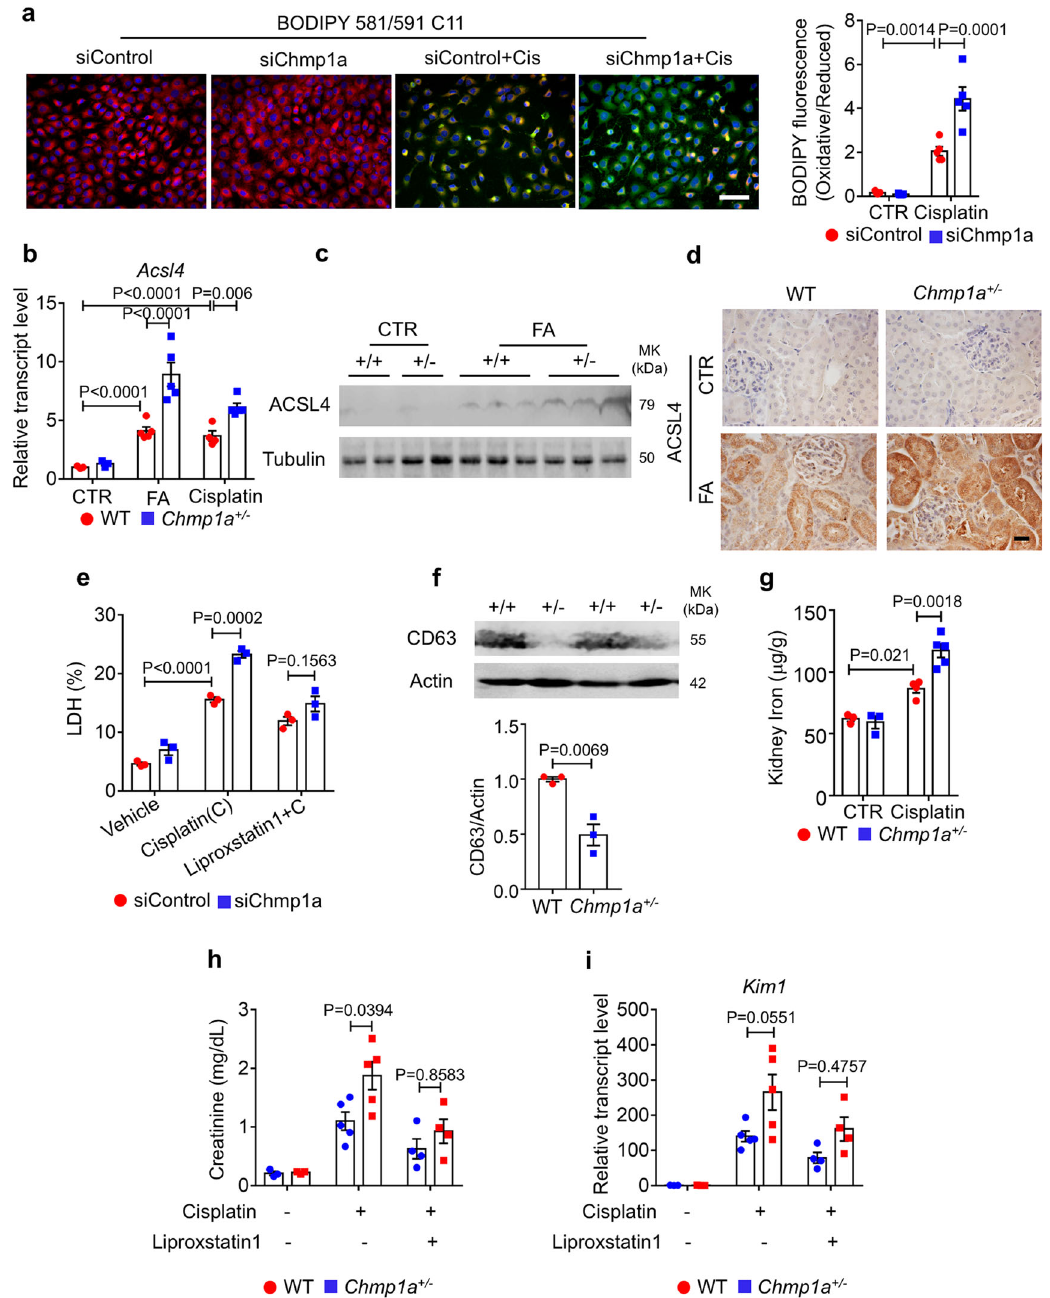
Fig. 7 Chmp1a knockdown enhanced ferroptosis through iron accumulation. a (left) Representative BODIPY 581/591 C11 staining of siControl and siChmp1a transfected cell following sham or cisplatin treatment. Scale bar: 50 μ m. (right) Quanti fi cation of the oxidized vs. reduced probe ( n = 5). b Relative mRNA level of Acsl4 in the kidneys of folic acid and cisplatin-treated wild-type and Chmp1a + / − mice. Sham-treated group: WT ( n = 3), Chmp1a + / − ( n = 3); FA-treated group: WT ( n = 5), Chmp1a + / − ( n = 5); cisplatin-treated group: WT ( n = 4), Chmp1a + / − ( n = 5). c Western blots of ACSL4 in kidneys of folic acid-treated wild-type and Chmp1a + / − mice. d Representative images of ACSL4 immunostaining of kidney sections from folic acid-treated wild-type and Chmp1a + / − mice. Scale bar: 10 μ m. e LDH level of siControl and siChmp1a transfected cell with or without cisplatin and ferroptosis inhibitor liproxstatin1 ( n = 3). f (upper) Western blots of CD63 of kidney exosomes of wild-type and Chmp1a + / − mice. (bottom) Quanti fi cation of three independent experiments ( n = 3). g Ferrous iron concentrations (normalized to kidney weight) of kidneys of cisplatin-treated wild-type and Chmp1a + / − mice. Sham-treated group: WT ( n = 3), Chmp1a + / − ( n = 3); cisplatin-treated group: WT ( n = 4), Chmp1a + / − ( n = 5). h Serum creatinine level of control and Chmp1a + / − mice with or without cisplatin and liproxstatin injection. Sham-treated group: WT ( n = 3), Chmp1a + / − ( n = 3); cisplatin-treated group: WT ( n = 5), Chmp1a + / − ( n = 5); cisplatin and liproxstatin-treated group: WT ( n = 4), Chmp1a + / − ( n = 4). i Relative transcript level of injury marker Kim1 in kidneys of control and Chmp1a + / − mice with or without cisplatin and liproxstatin injection. Sham-treated group: WT ( n = 3), Chmp1a + / − ( n = 3); cisplatin-treated group: WT ( n = 5), Chmp1a + / − ( n = 5); cisplatin and liproxstatin-treated group: WT ( n = 4), Chmp1a + / − ( n = 4). All data are represented as mean ± SEM. P value was calculated by two-way ANOVA with post hoc Tukey test for a , b , e , g , h , i . P value was calculated by two-tailed t -test for f . P < 0.05 is statistically signi fi cant. A Source Data fi le is available for this fi